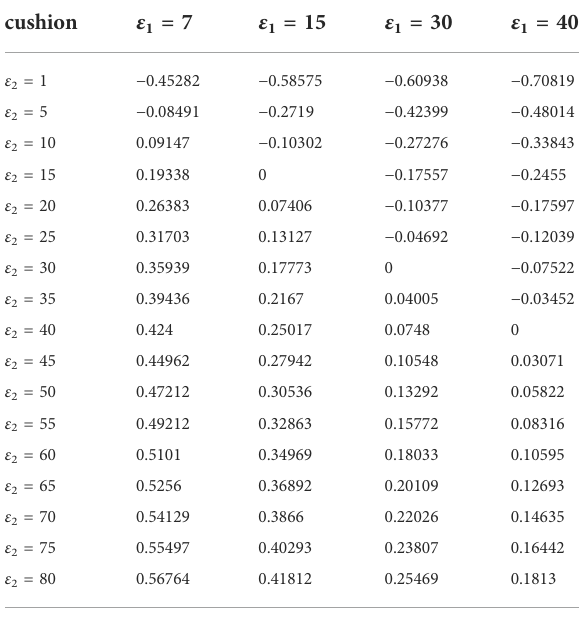
TABLE 3 Echo amplitude in the geoelectrical model (the relative wave amplitude at the masonry-metal interface is 1). Surface